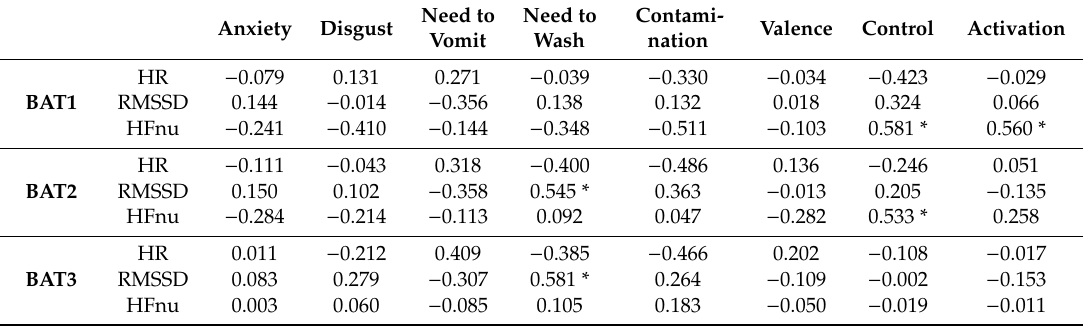
Table 1. Pearson correlation coe ffi cients in subclinical OCD-contamination group during the BAT. Need to Anxiety Disgust